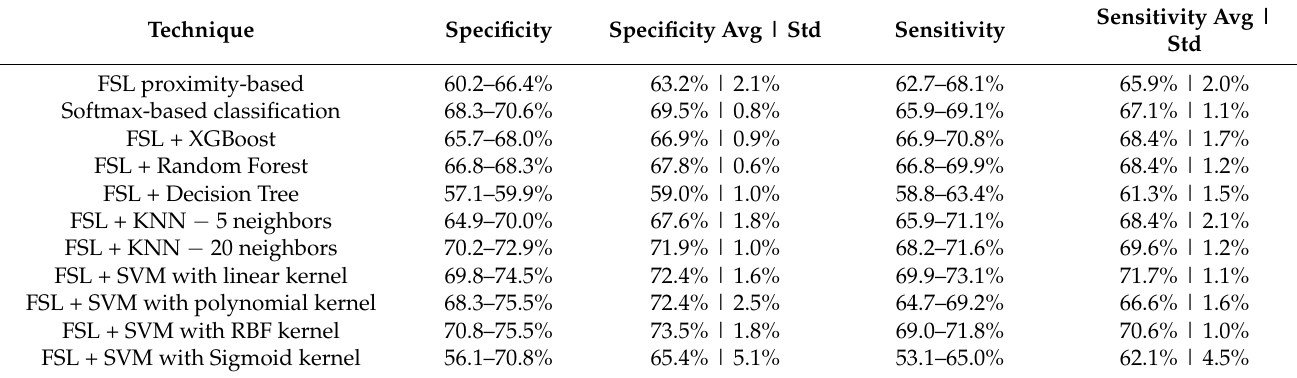
Table 5. Results for five-class classification, part